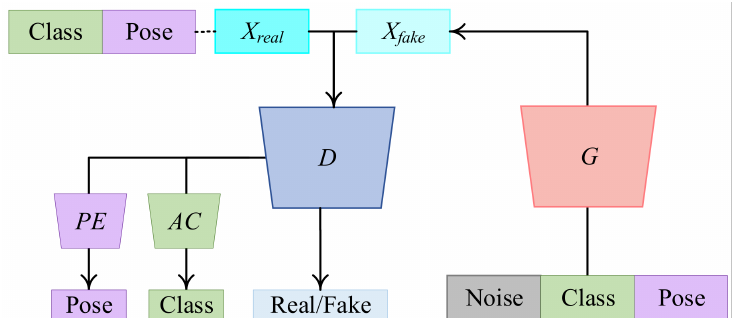
Figure 1. Overall architecture of our proposed PeaceGAN. The model is composed of four compo- nents: a generator ( G ), a discriminator ( D ), a pose estimator ( PE ), and an auxiliary classifier ( AC ). After training finishes, the generator can produce abundant SAR target images with intended target classes at desired pose